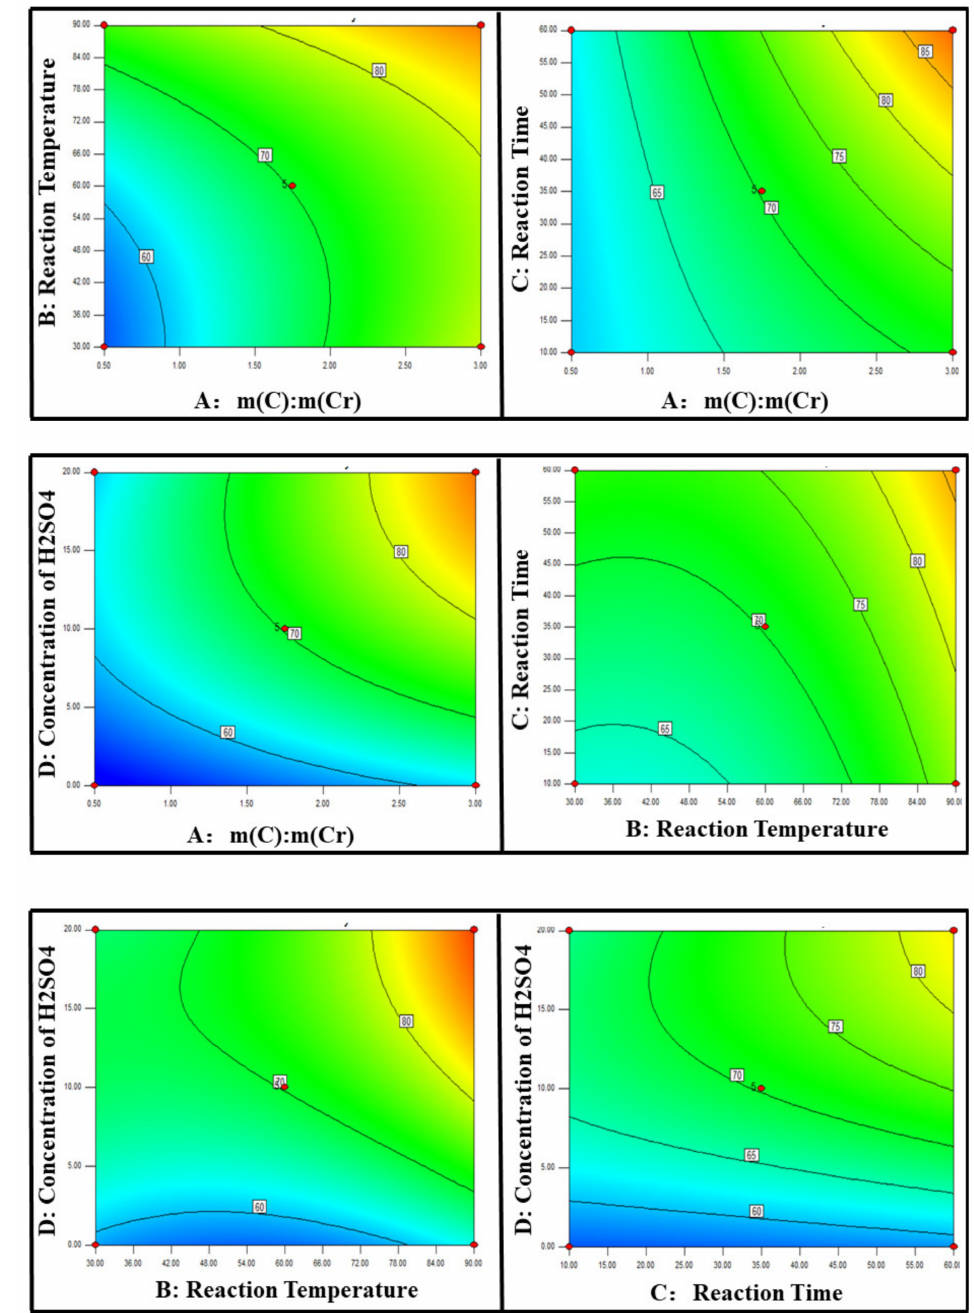
Figure 5. Response surface plots for the